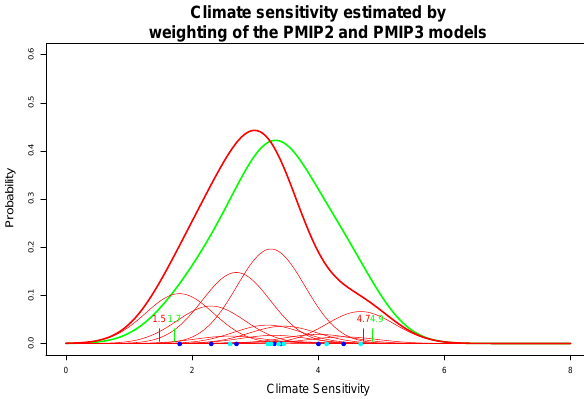
Fig. 5. Using LGM tropical temperature as a constraint on climate sensitivity. Cyan and blue dots represent PMIP2 and CMIP5 sim- ulations respectively. Linear regression and predictive uncertainty range are plotted as solid and dashed blue lines respectively. Small red dots represent a Monte Carlo sample from the estimated proxy- derived reconstruction, mapped onto the climate sensitivity.